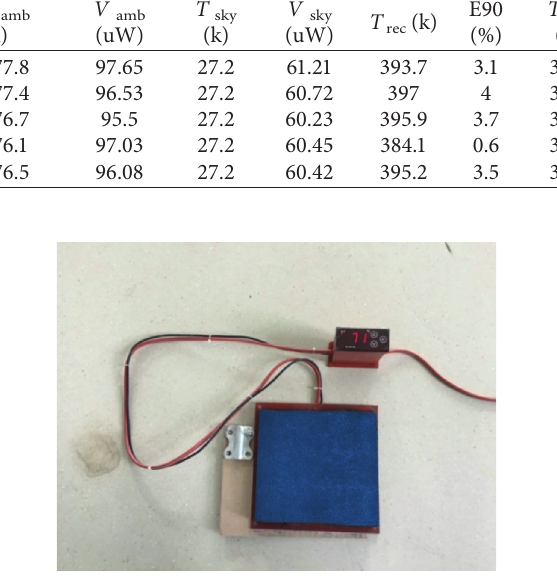
Figure 11: Design of the hot blackbody load.